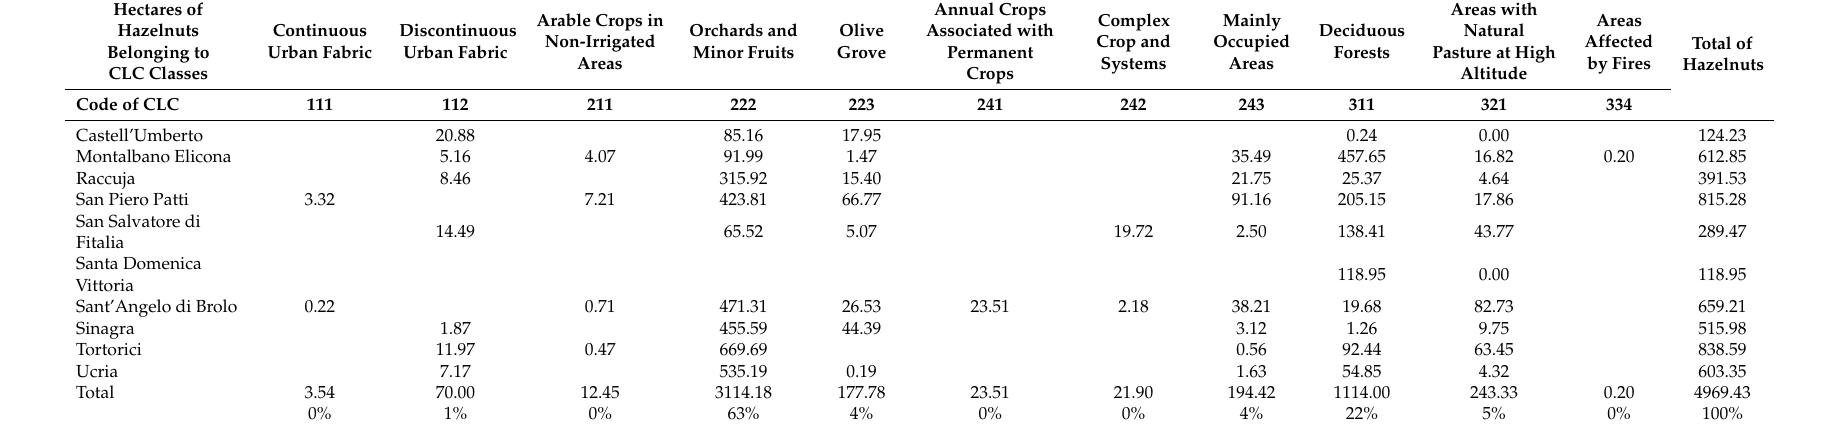
Table 1. Hectares of hazelnuts belonging to vegetation map overlapped to CLC classes for each